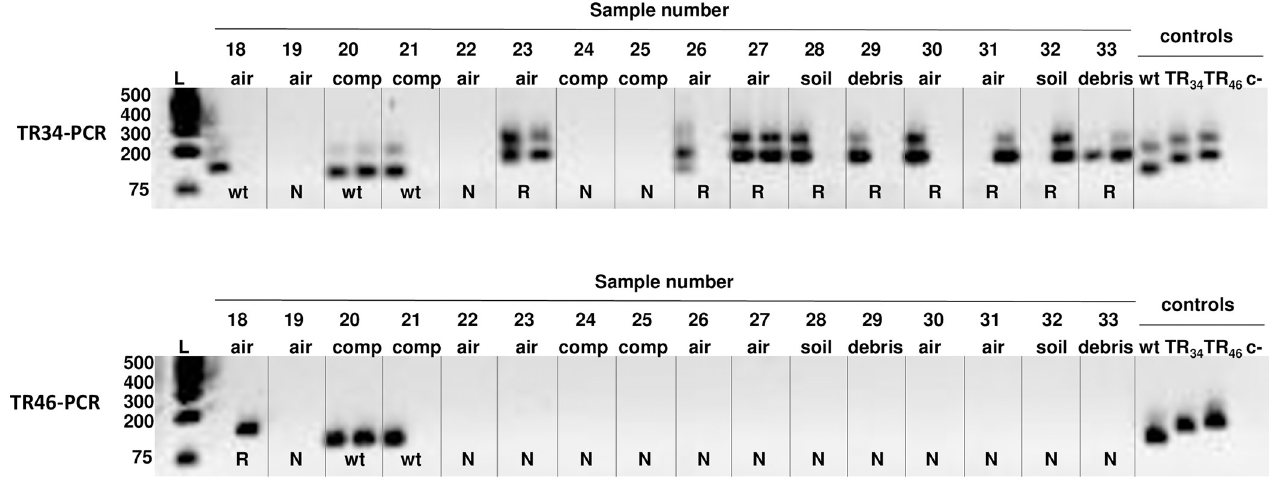
Fig 3. Gel image of 16 of the environmental samples, including air, compost (comp), soil, and plant debris (debris), assayed by TR34-PCR and TR46-PCR. Sample numbers above each lane correspond with samples in Table 1. DNA was extracted from each sample which was processed in duplicate for the nested PCR assays. Samples showing bands in one or both replicates were considered positive for A . fumigatus . The 2.5% agarose gel allows the differentiation of the wt allele from the TR 34 and TR 46 resistance alleles. Samples with the A . fumigatus wt allele for the cyp51A promoter yield PCR products of 100 bp and 103 bp for TR34-PCR and the TR46-PCR, respectively. Samples with the resistant alleles produce PCR products that are 134 or 146 bp for TR34-PCR or 137 or 149 bp for TR46-PCR. These samples are considered resistant (R) and undergo high-definition electrophoresis on a 4% gel to distinguish the TR 34 and TR 46 alleles. Samples without an amplification product were considered negative